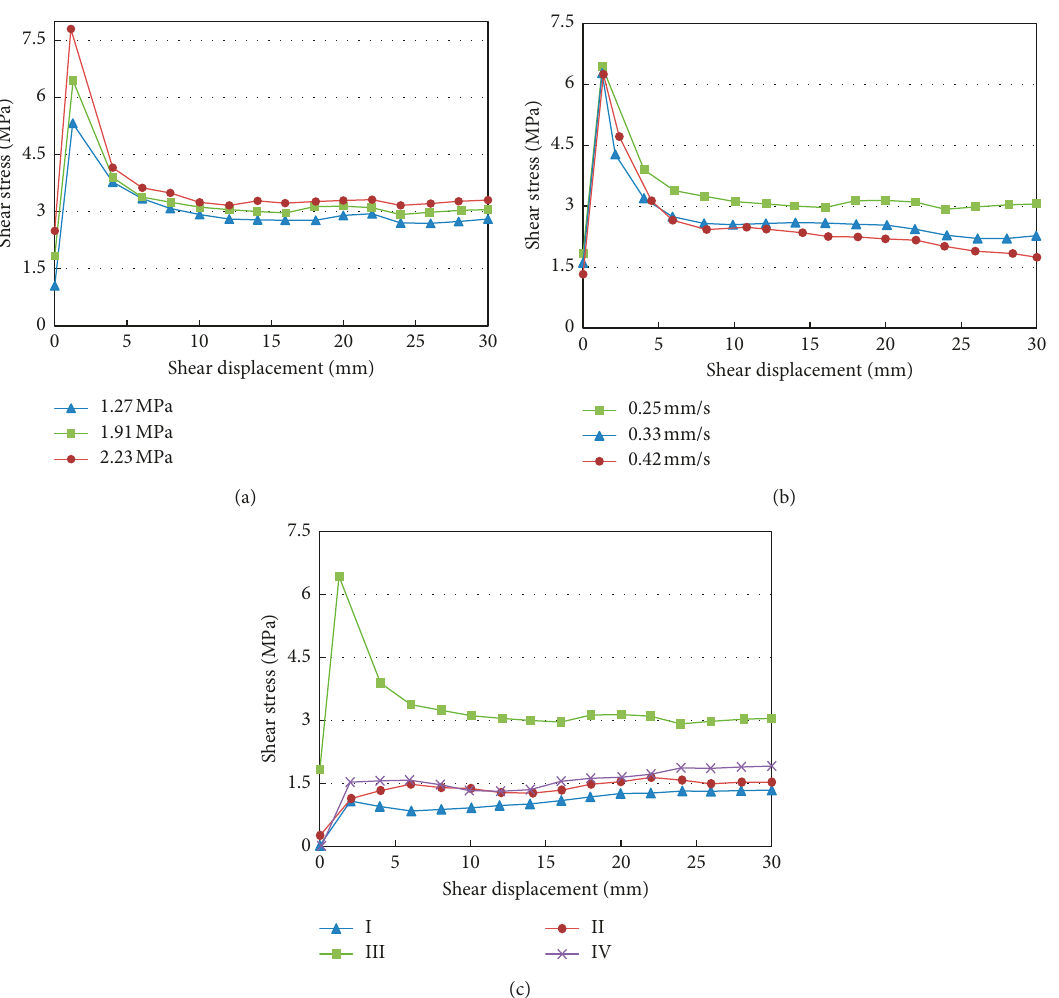
Figure 6: Evolution of shear stress with increasing shear displacement. (a) Increasing normal stress. (b) Increasing shear velocity. (c) Changes in the fissure plane combination mode.